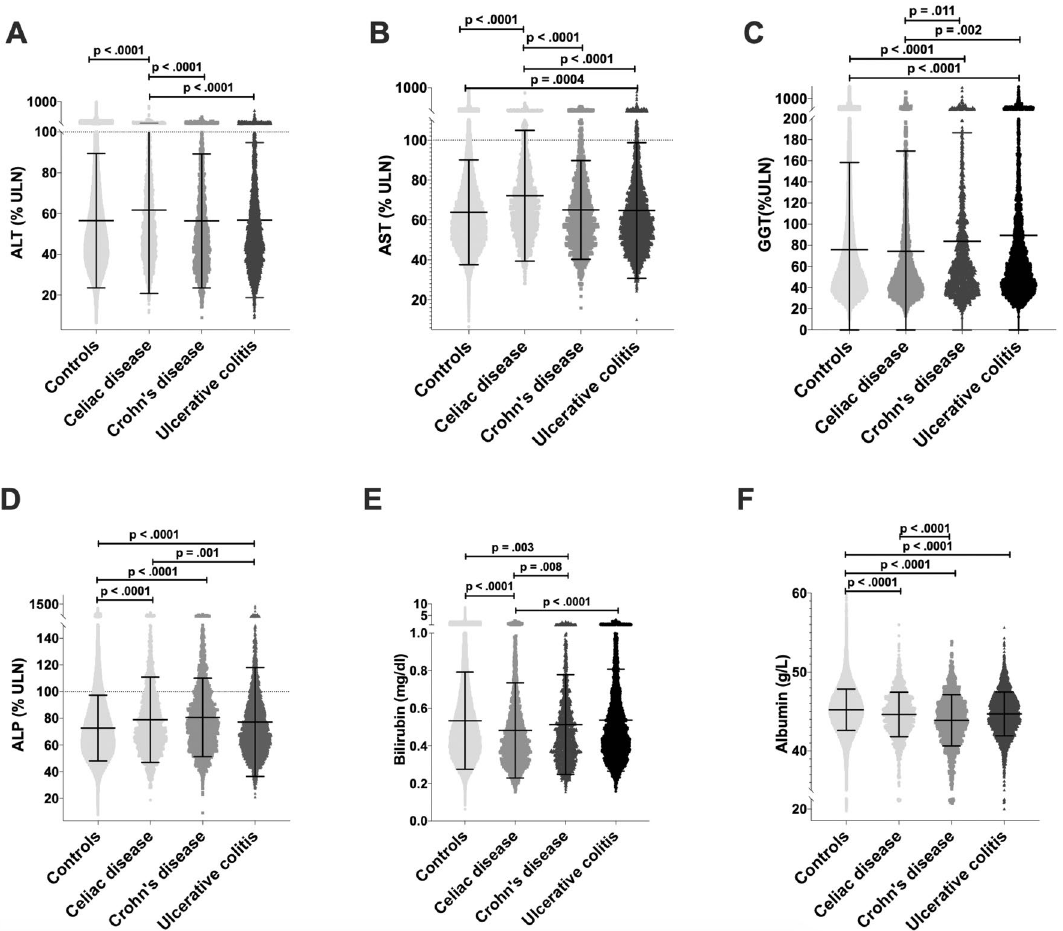
Figure 1. Liver related parameters in individuals with celiac disease, Crohn’s disease, and ulcerative colitis compared to healthy controls. 488,941 control participants. 2377 subjects with diagnosis of celiac disease. 1738 individuals with Crohn’s disease and 3684 participants with ulcerative colitis underwent laboratory analysis. p values were adjusted for age, sex, BMI, alcohol consumption and diabetes mellitus using a linear regression model. Scatter plots of serum level of aspartate aminotransferase (AST; A ), alanine aminotransferase (ALT; B ), gamma glutamyl transferase (GGT; C ); and alkaline phosphatase (ALP; D ) are shown, all normalized to the sex- specific upper limit of normal (ULN) (marked as dotted line). Scatter plot of serum levels of bilirubin ( E ) and albumin ( F